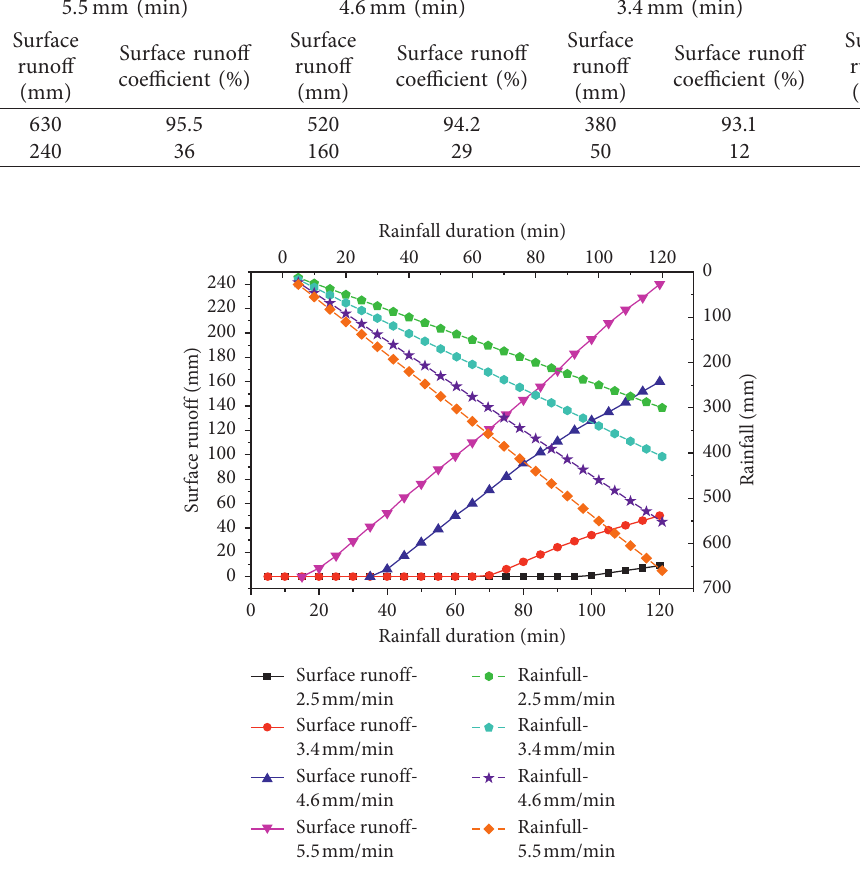
Figure 9: Large-void asphalt pavement.